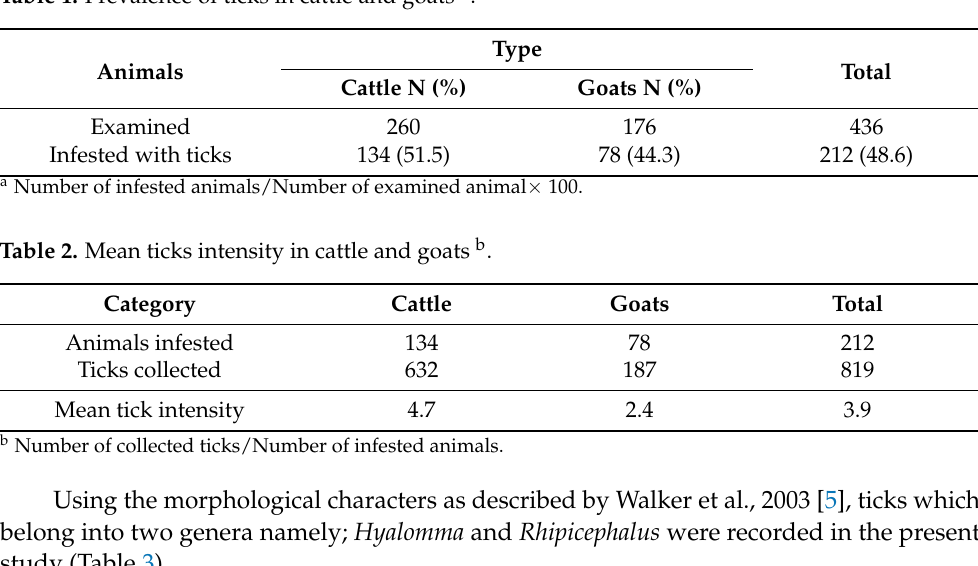
Table 1. Prevalence of ticks in cattle and goats a .